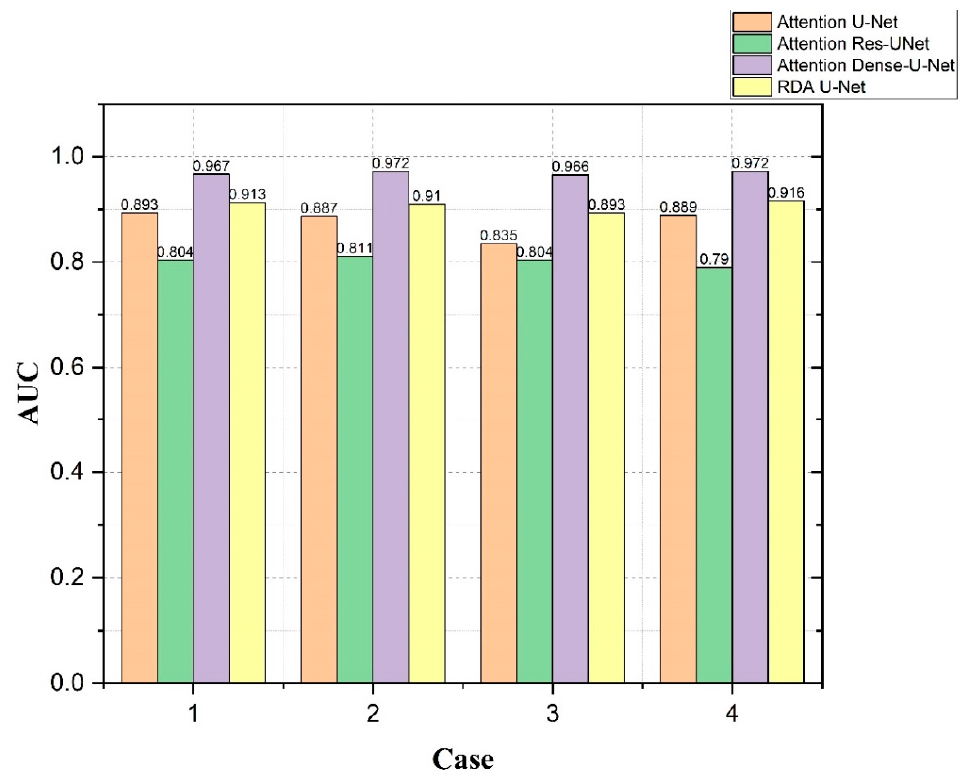
Figure 10. Comparison of ROC values using Attention U-Net, Attention Res-UNet, Attention Dense- U-Net and our RDA U-Net for each of the 4 cases.